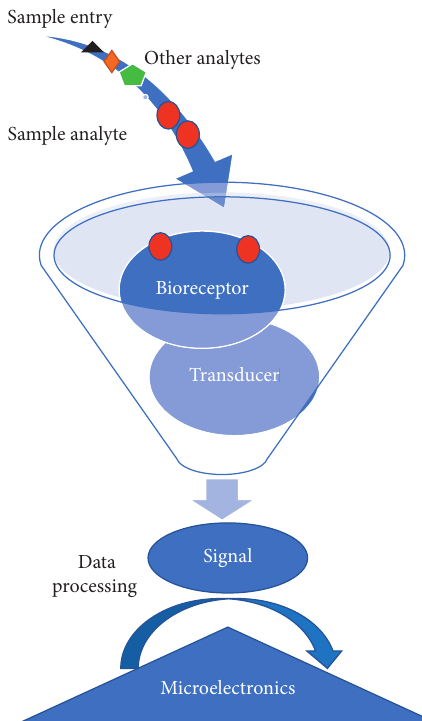
Figure 1: The quantitative and qualitative identification of the component by recording and presenting the